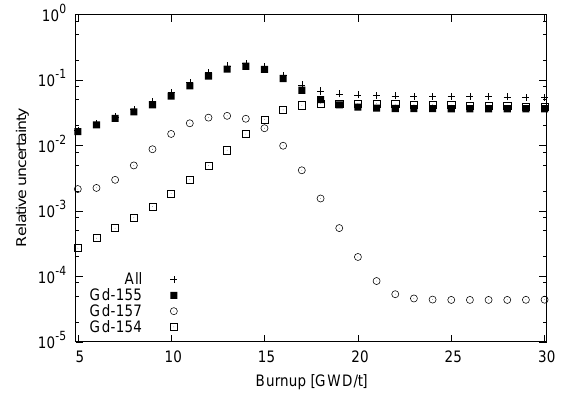
Figure 10. Nuclear data-induced uncertainty in Gd-155 number density during